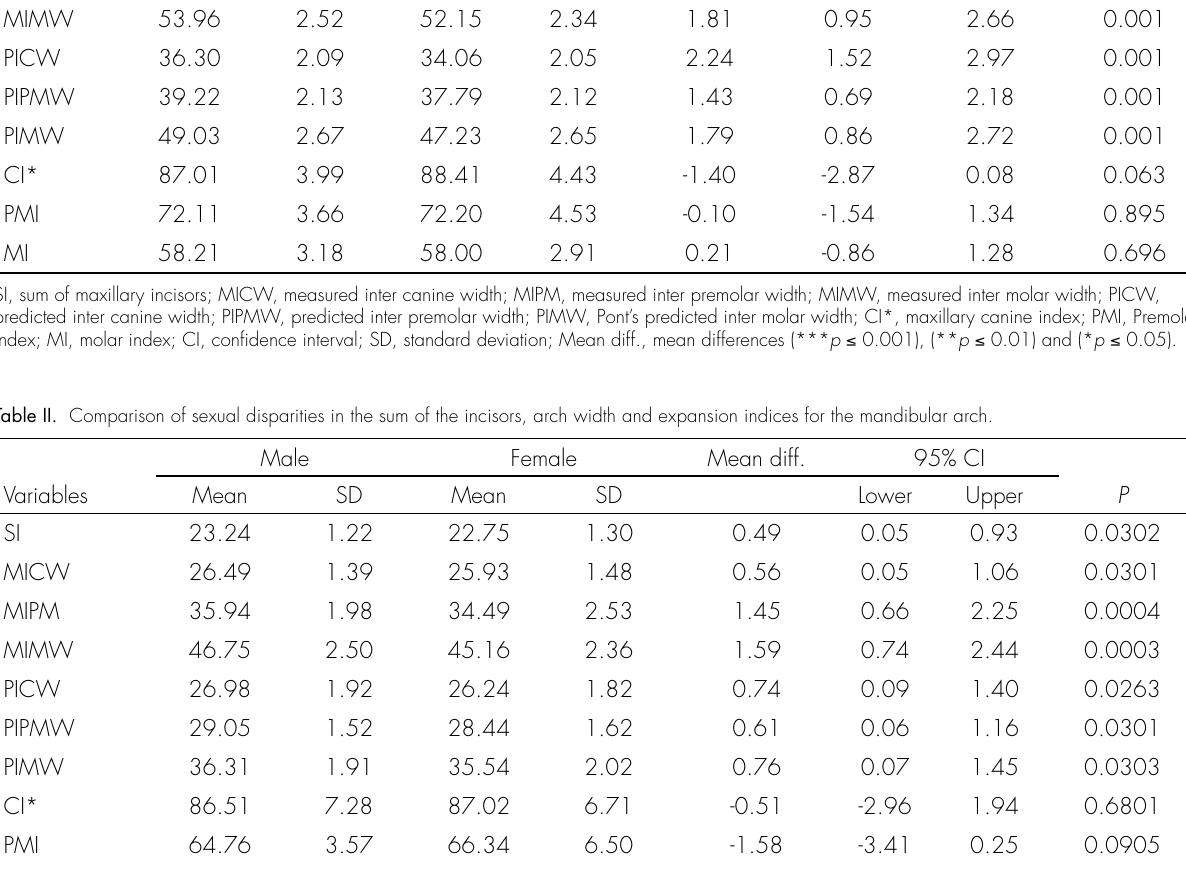
SI, sum of mandibular incisors; MICW, measured inter canine width; MIPM, measured inter premolar width; MIMW, measured inter molar width; PICW, predicted inter canine width; PIPMW, predicted inter premolar width; PIMW, predicted inter molar width; CI*, maxillary canine index; PMI,